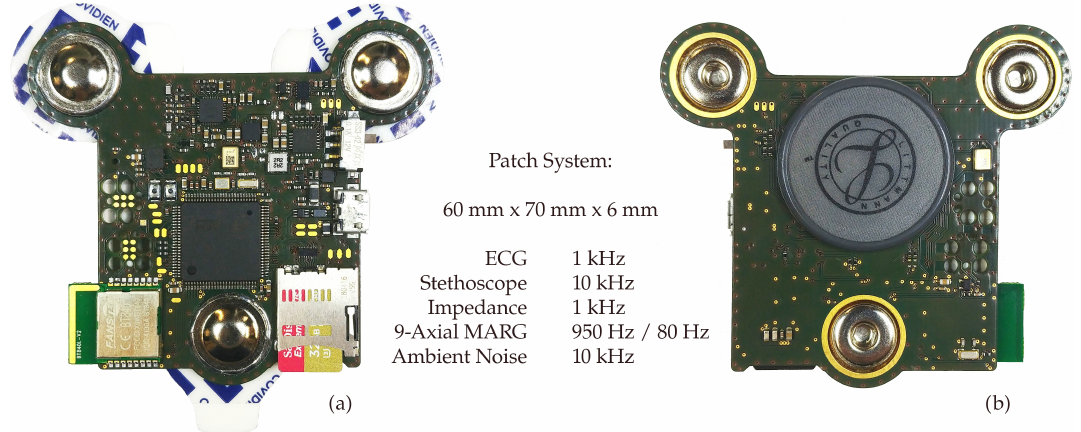
Figure 1. The wearable multimodal stethoscope patch. ( a ) Front view. ( b ) Back view with ECG / IP electrode connectors and 28 mm infant stethoscope membrane.